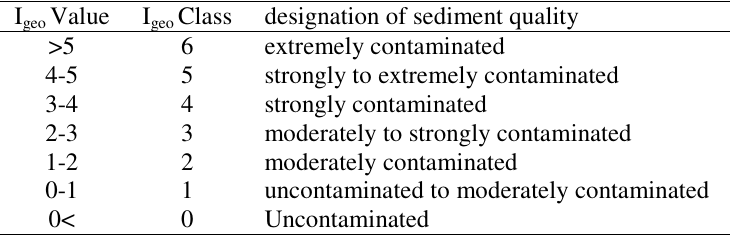
Table 1. The degree of metal pollution in terms of seven enrichment classes